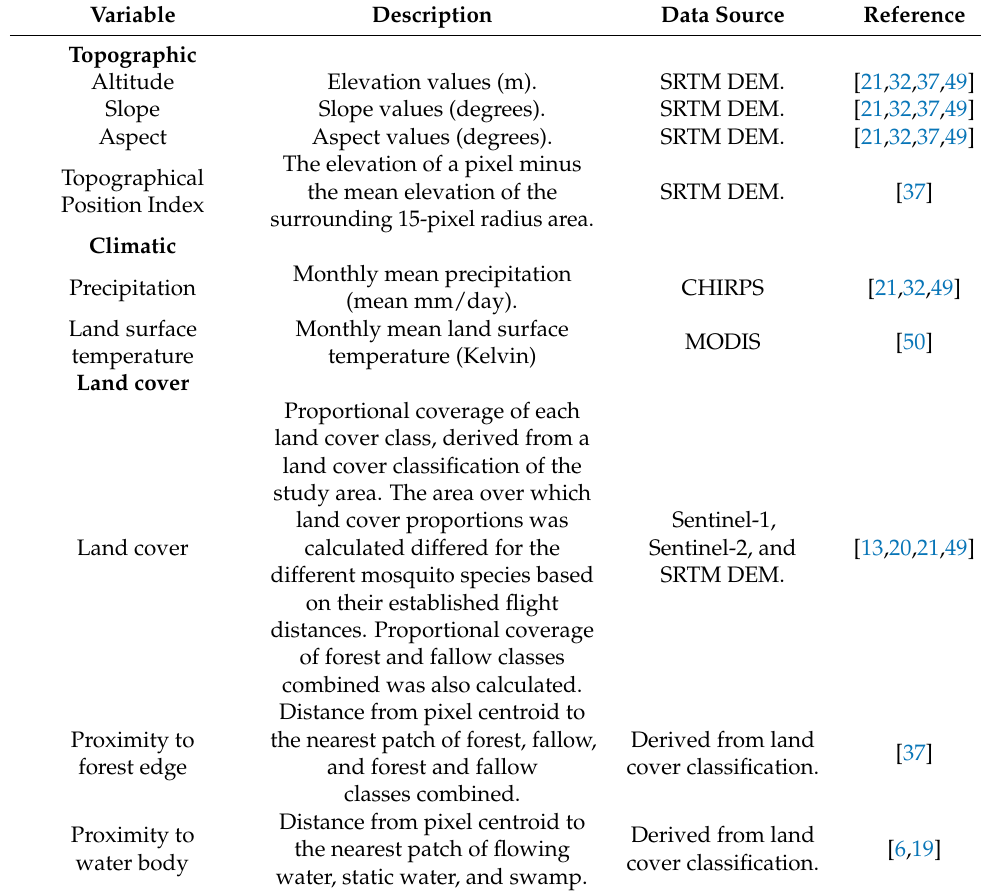
Table 1. Bio-geographical variables previously identified as being of relevance to mosquito distribu- tions and/or malaria transmission. SRTM DEM refers to the 30 m spatial resolution Shuttle Radar Topography Mission (SRTM) Digital Elevation Model (DEM). CHIRPS refers to the Climate Hazards Group InfraRed Precipitation with Station data precipitation